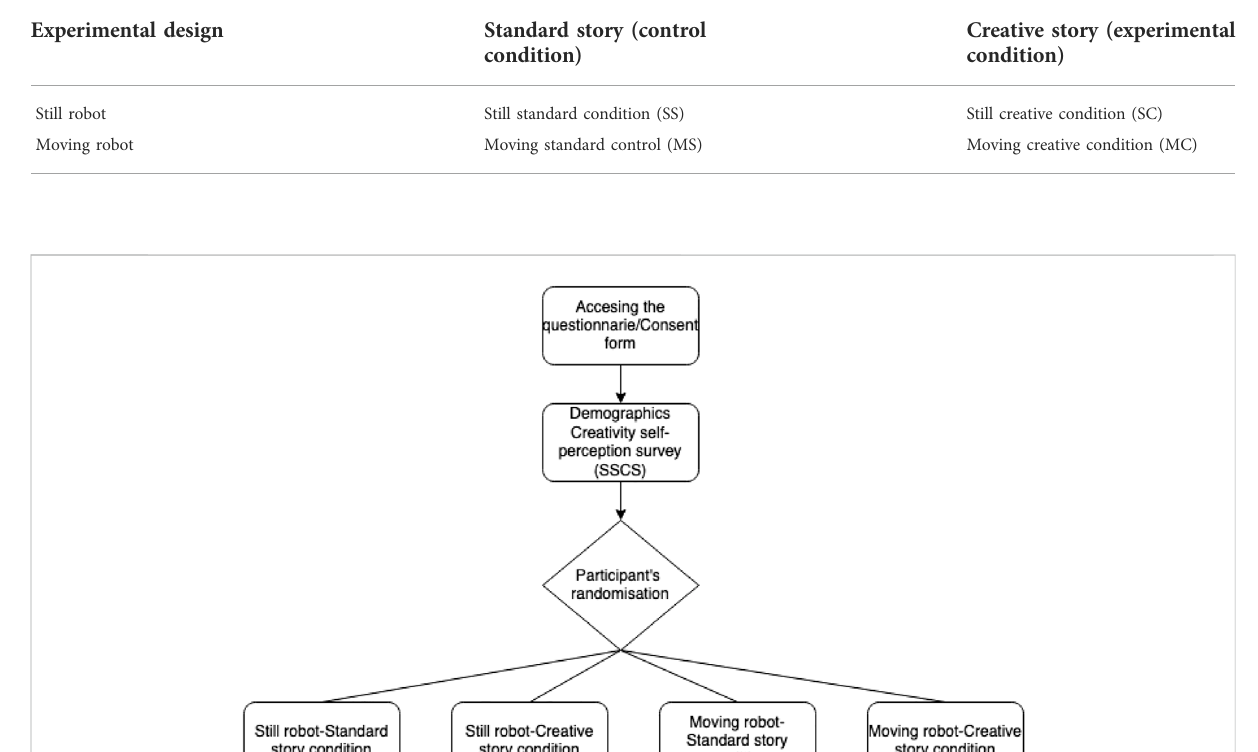
TABLE 1 Four experimental conditions. Each condition shows the factorial combination displaying a particular performance of the robot.